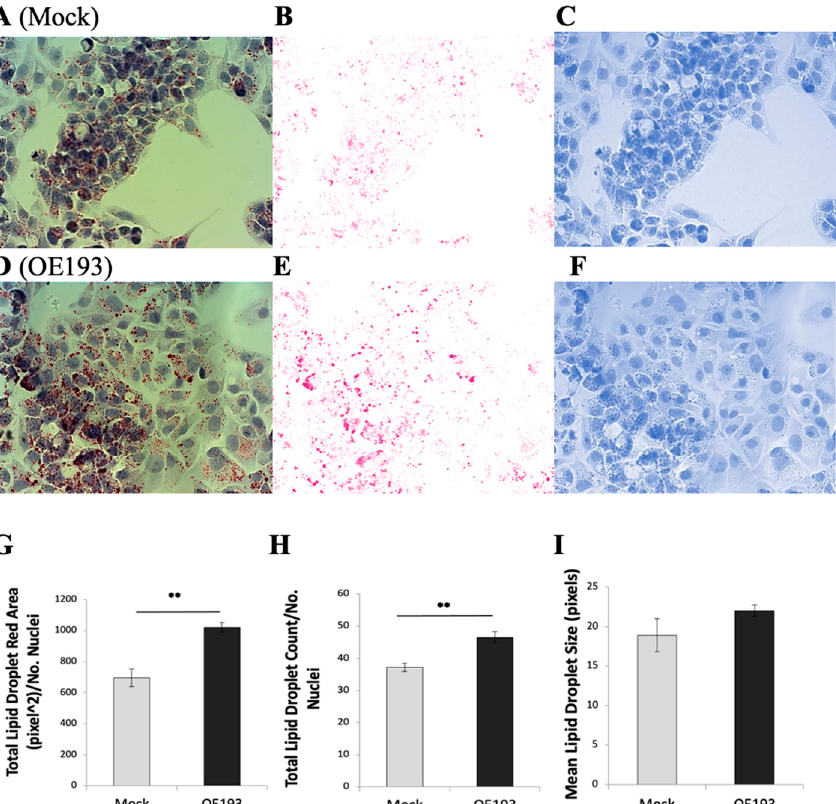
Figure 2. MicroRNA hsa-miR-193b-3p overexpression in HepG2 cells increases intracellular lipid droplet accumulation. HepG2 cells cultured at 20 mM glucose. Lipid droplets in HepG2 cells were visualized using Oil Red O staining. Brightfield 40 × magnification images of Oil Red O staining in control mock transfection ( A ) with corresponding red ( B ) and blue ( C ) color deconvolution. Bright- field 40 × magnification images of Oil Red O staining after microRNA hsa-miR193b-3p overexpression ( D ) with corresponding red ( E ) and blue ( F ) color deconvolution. Red color deconvolution used for red particle analysis; blue color deconvolution used for nuclei counting. Quantitative analysis of lipid droplet area ( G ), lipid droplet number ( H ) and lipid droplet size ( I ). Data are presented as mean ± SEM of n = 4; each n is average of ten fields per condition normalized to number of nuclei. Mock—mock transfection, OE—overexpression of hsa-miR-193b-3p. Student’s t -test p -value ** < 0.01.